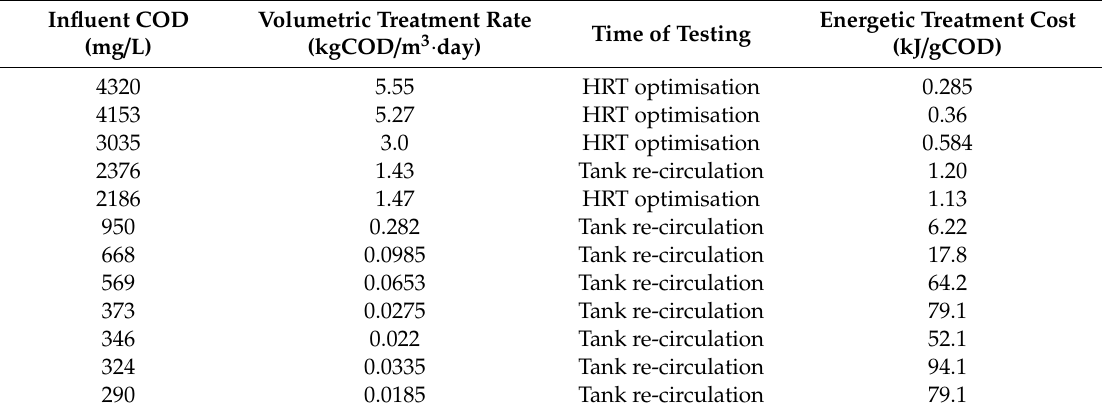
Table 3. Average VTRs from di ff erent influent CODs when subject to a flow rate of 3 L /